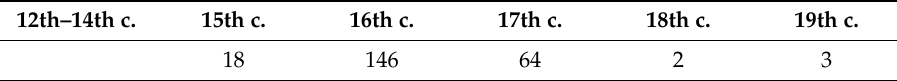
Table 1. Absolute construction frequencies over the